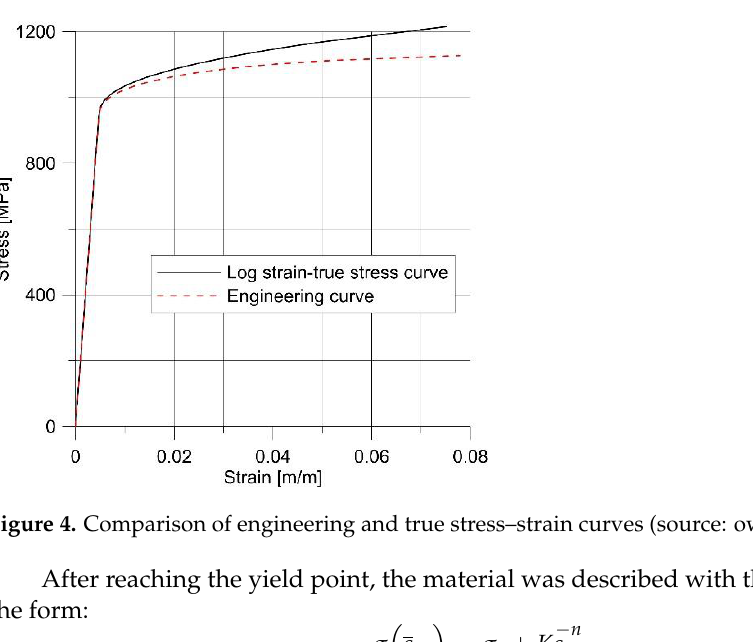
Table 1. Chemical composition of Inconel 718 alloy (source: [7]).